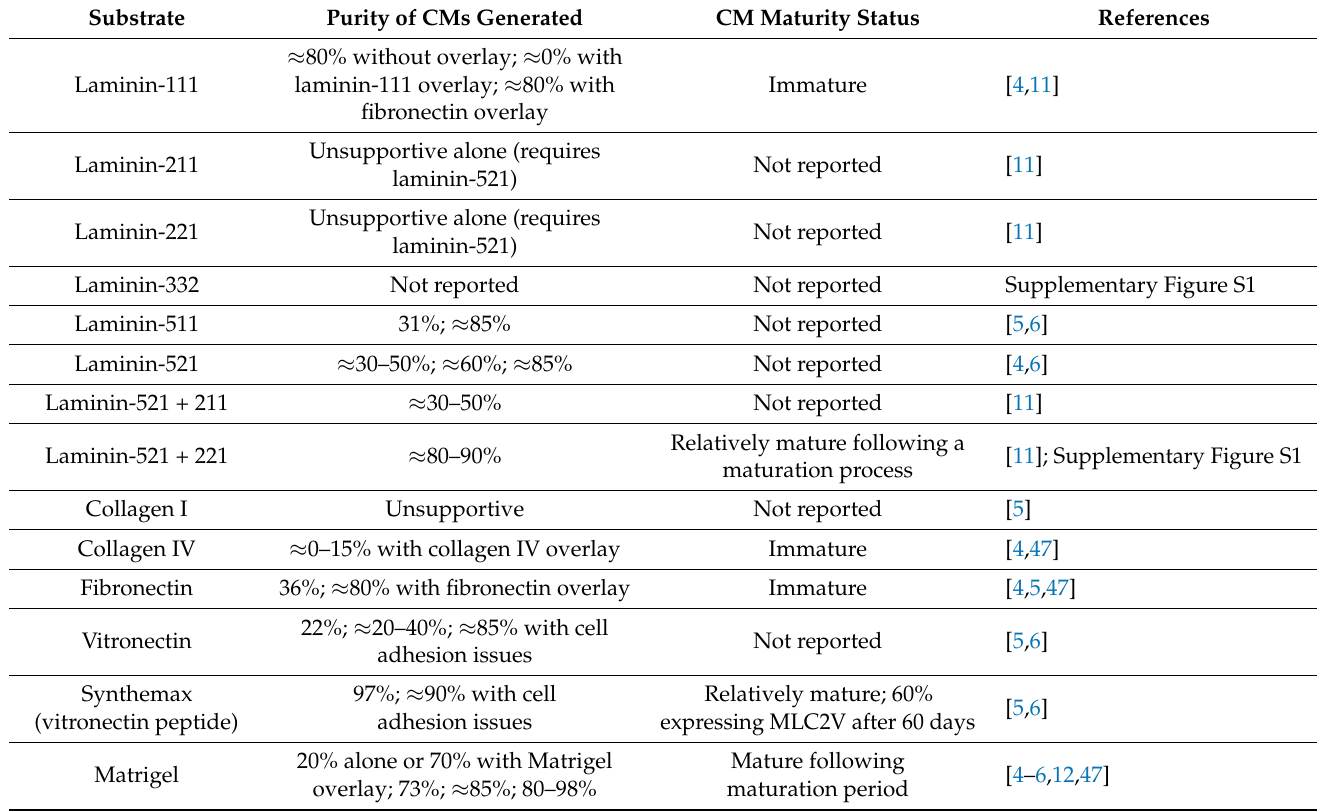
Table 2. Substrates investigated and compared for their ability to support hESC- or iPSC-CM